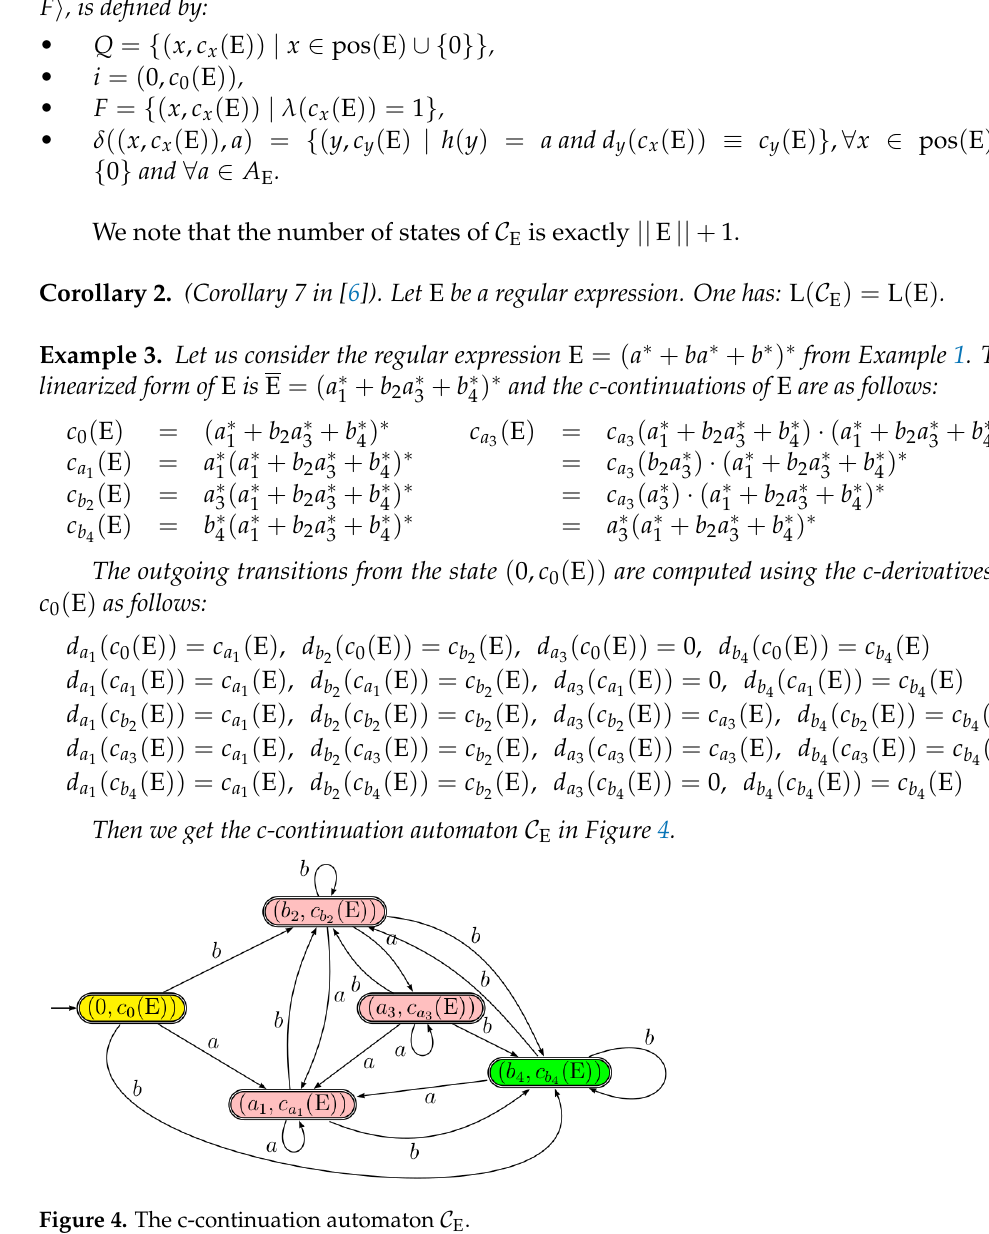
Figure 4. The c-continuation automaton C E